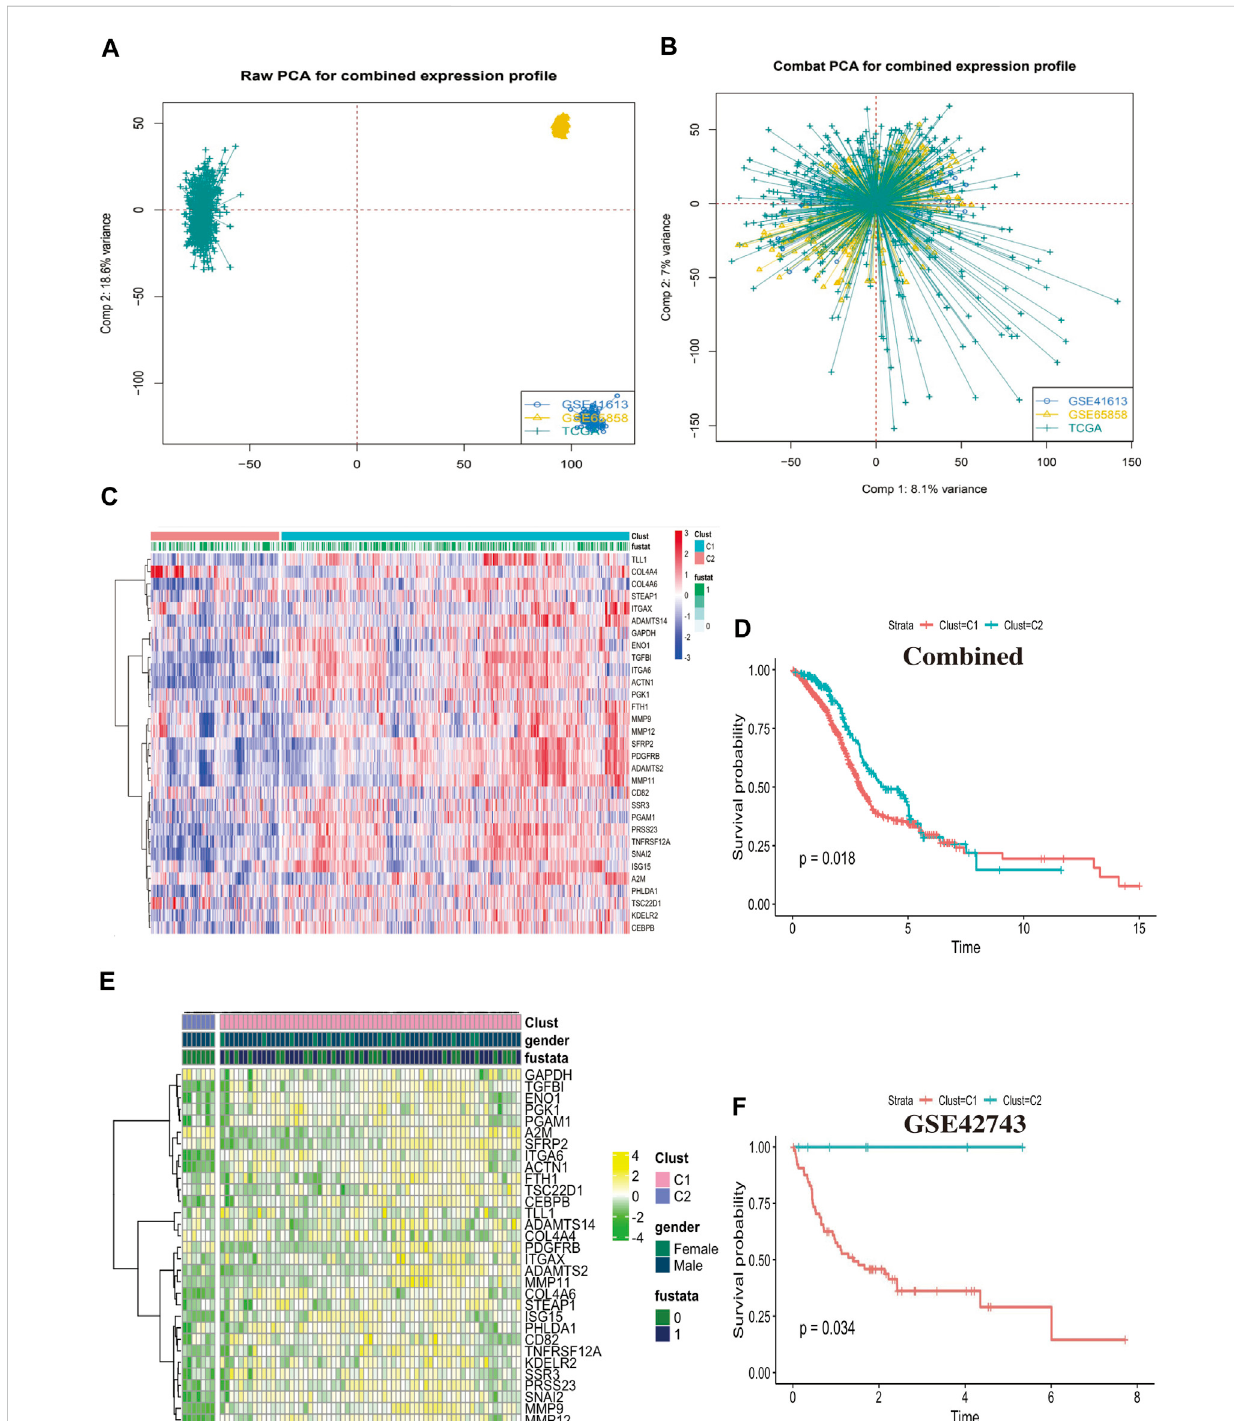
FIGURE 3 Clusteringanalysisidenti fi edtwoCAFspatterns. (A) Principalcomponentanalysis(PCA)showedthegeneexpressionpro fi leinthecombinedcohort, before elimination of the batch effects. (B) Principal component analysis (PCA) showed the gene expression pro fi le in the combined cohort after elimination of the batch effects. (C) The heatmap displays the differential expression between the two groups of the 31 cancer associated fi broblasts (CAFs) genes, C1 cluster, C2 cluster, “ 1 ” means dead, “ 0 ” means alive, “ fustat ” means survival status. (D) The Kaplan-Meier plot displays signi fi cant differences survival rate among the two kinds of CAFs phenotypes in the Combined cohorts. C1 was worse than C2 (log rank p = 0.018), unit of Time (years). (E) The heatmap displays the differential expression between the two groups of the 31 cancer associated fi broblasts (CAFs) genes in the external cohort GSE42743. (F) The Kaplan-Meier plot displays the same trend of signi fi cant differences survival rate among the two kinds of CAFs phenotypes in the external cohort GSE42743 (log rank p =